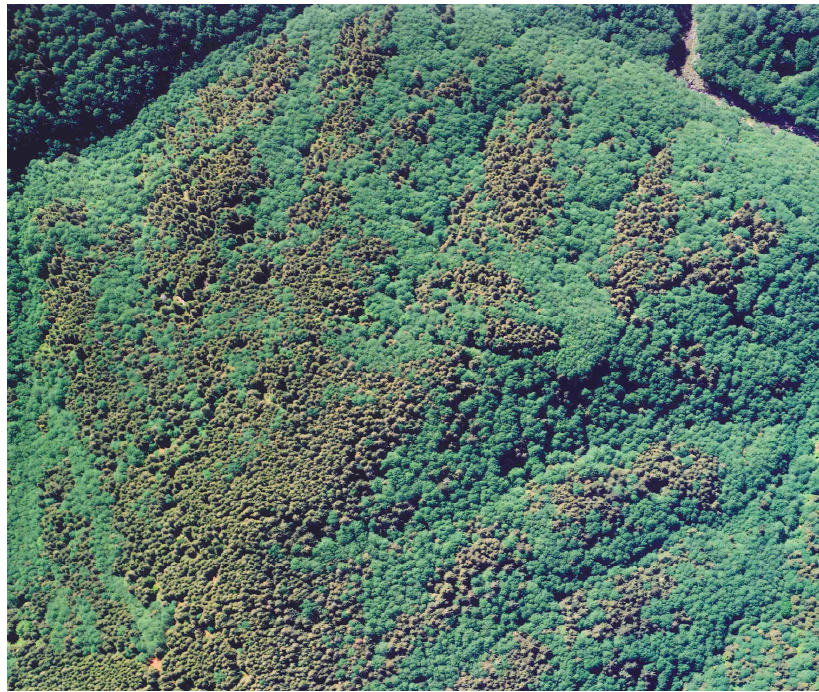
Figure 2. Mixed species stand with severe SNC infection (brown foliage). Light green trees are hardwoods (red alder).